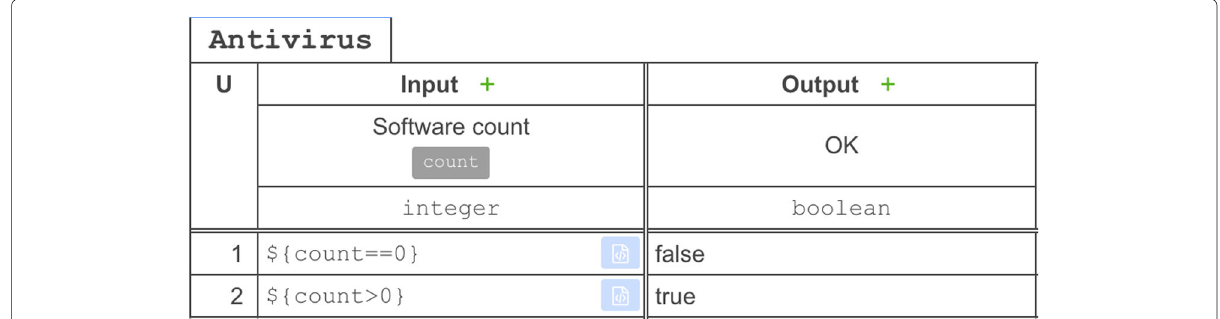
Fig. 12 DMN Decision table for antivirus installation